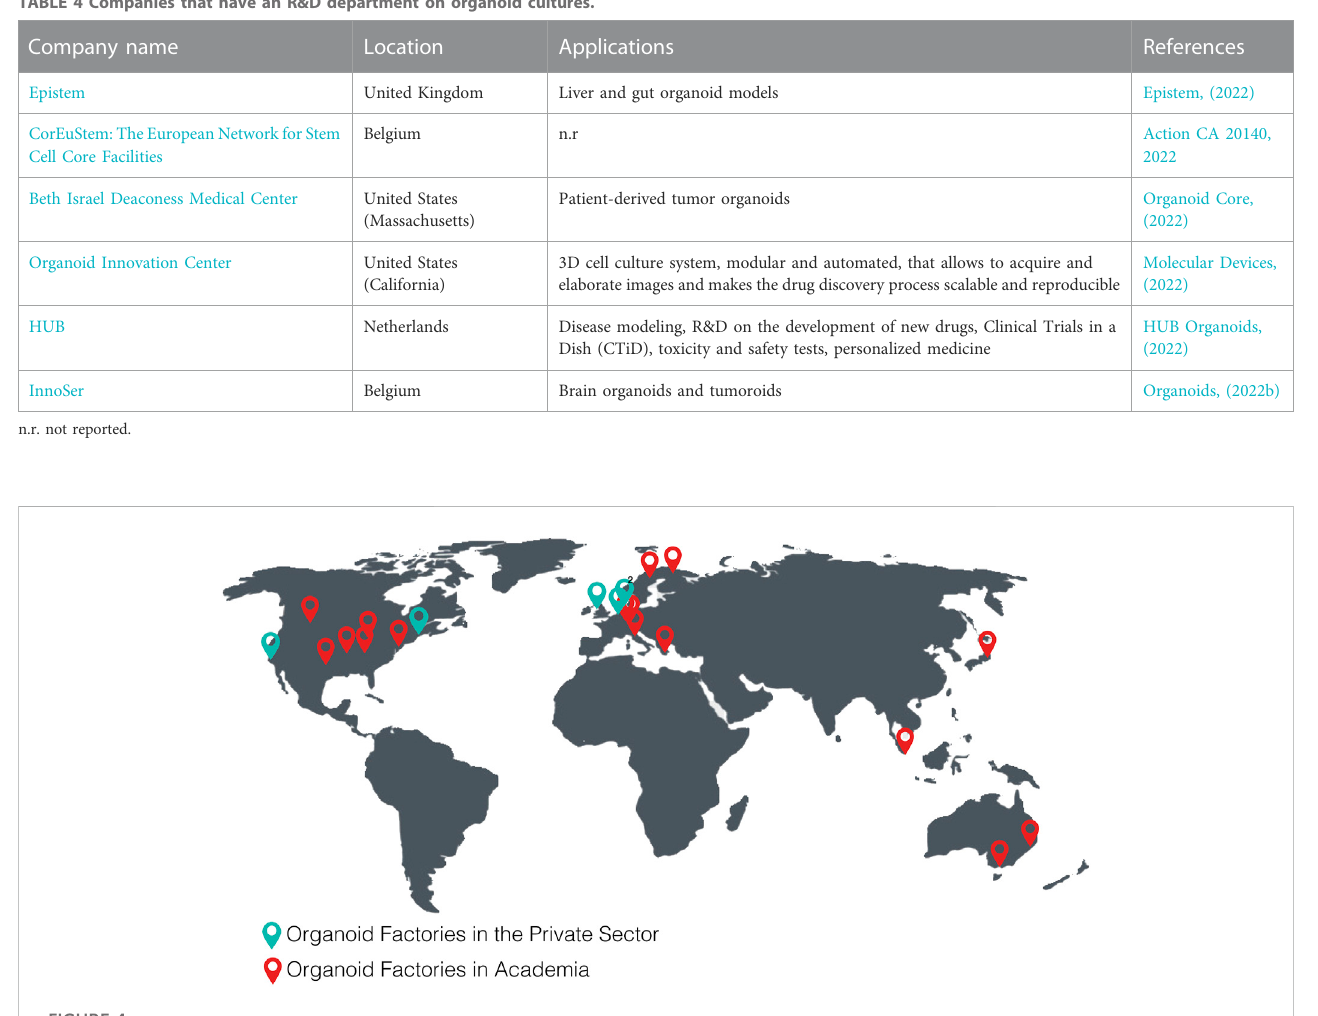
FIGURE 4 World distribution map of the organoid factories in academia and in the private